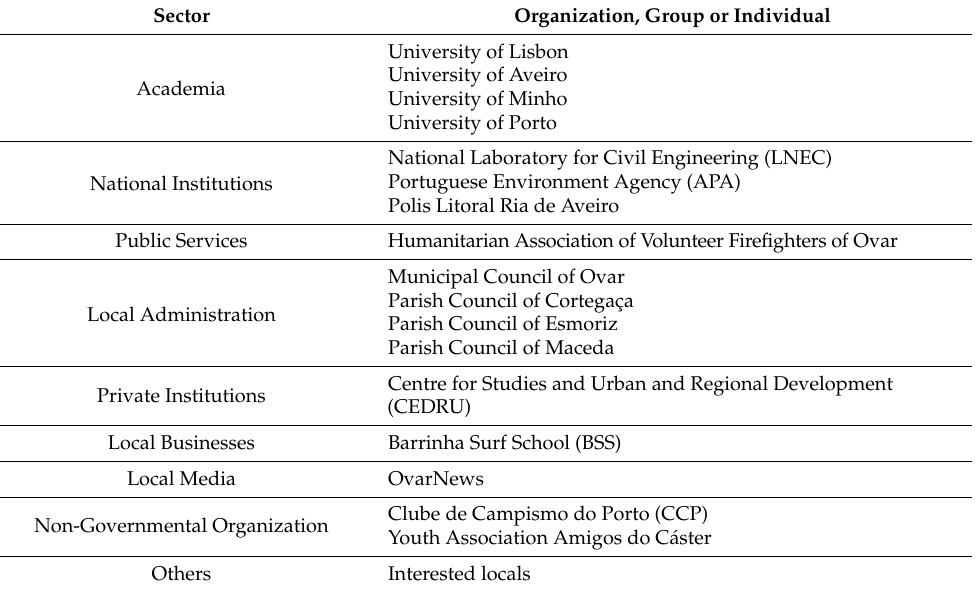
Table 1. Stakeholder sectors and groups that participated in the